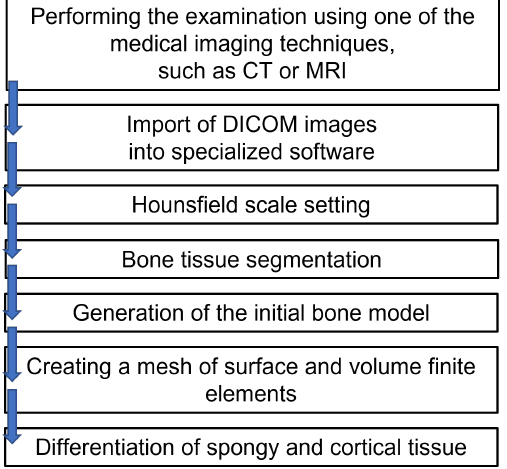
Figure 2. The method of modeling the femur model.